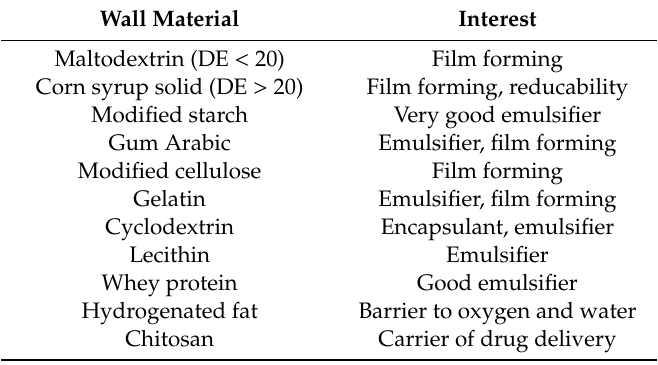
Table 2. Wall materials commonly used in the spray drying